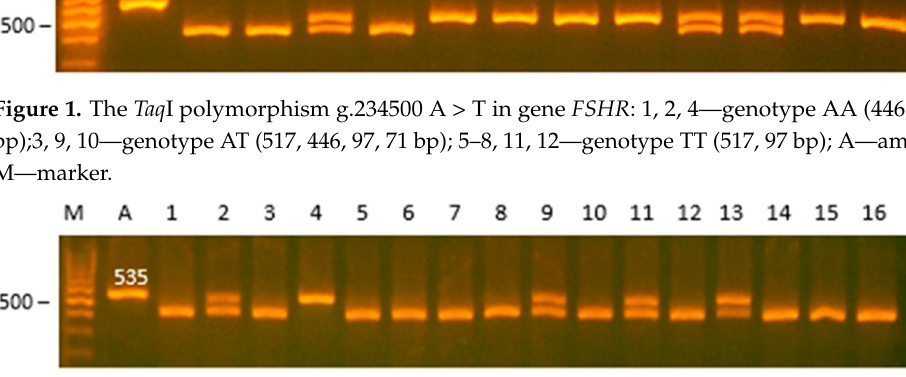
Figure 2. The Hind III polymorphism g.1536 C > T in gene TNP2 : 1, 3, 5–8, 10, 12, 14–16—genotype TT (432, 103 bp); 2, 9, 11, 13—genotype CT (535, 432, 103 bp); 4—genotype CC (535 bp); A—amplicon; M—marker.